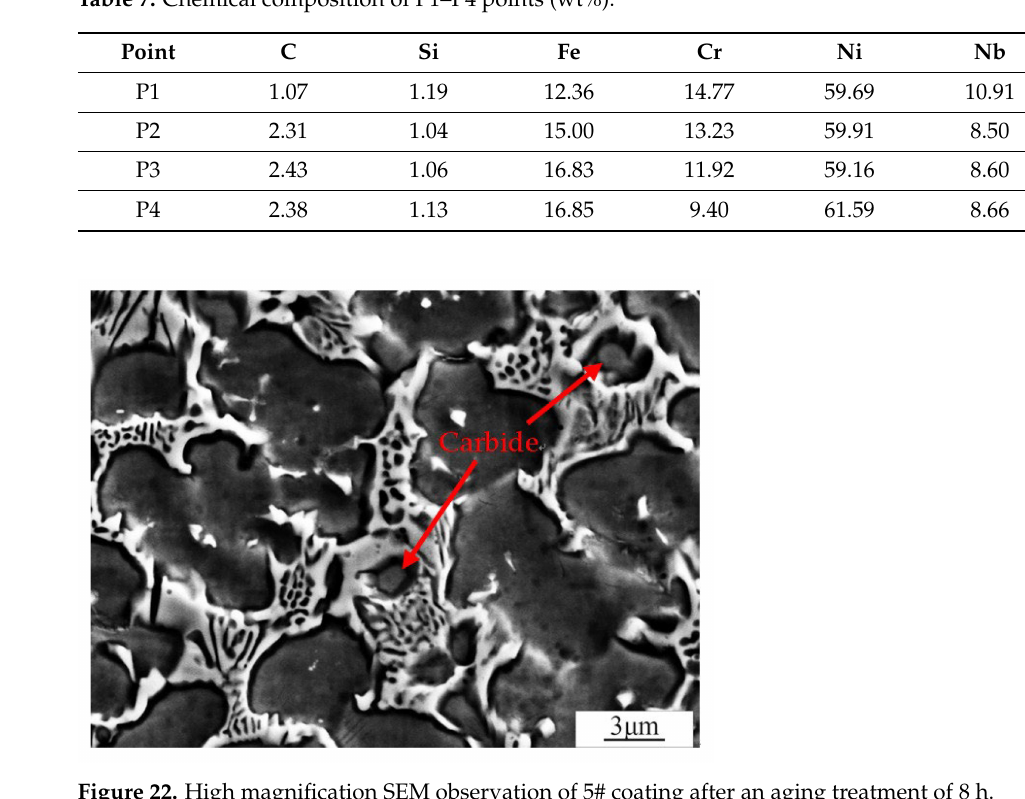
Figure 22. High magnification SEM observation of 5# coating after an aging treatment of 8